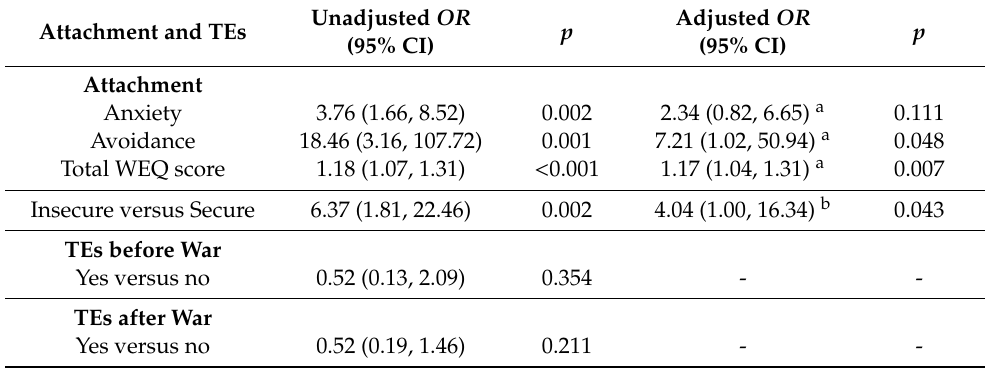
Table 2. Association between attachment dimensions and non-war-related traumatic events and lifetime posttraumatic stress disorder—both crude and